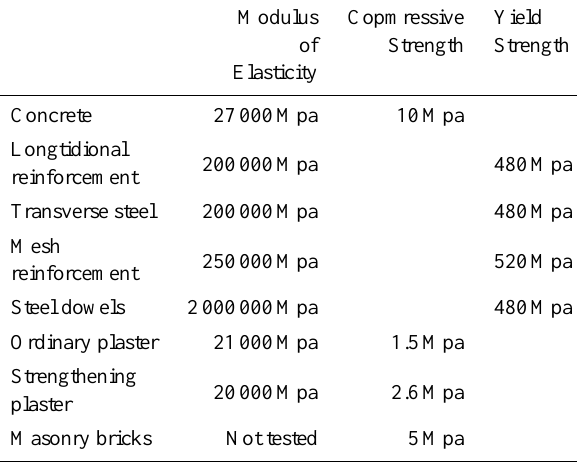
Table 2. Mechanical properties of the materials.